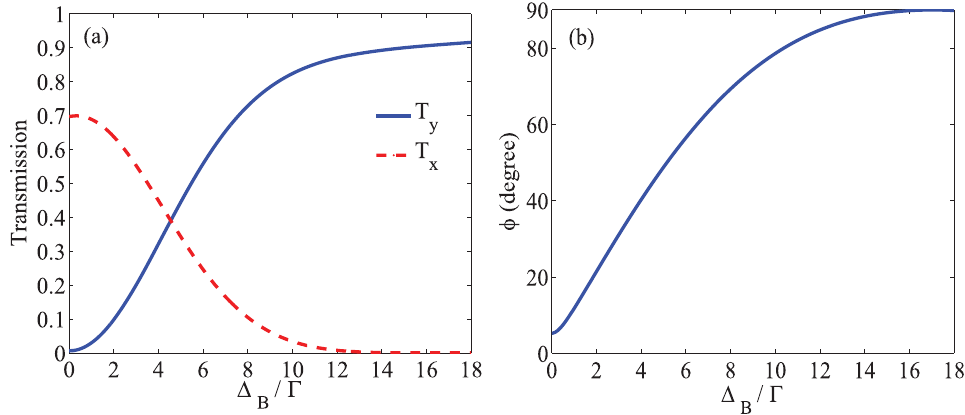
Figure 5. Intensity of the transmission ( a ) in ˆ x (dashed) and ˆ y (solid) directions and the MOR angle ( b ) versus Δ . The taken parameters are the same used in Fig. 4. B